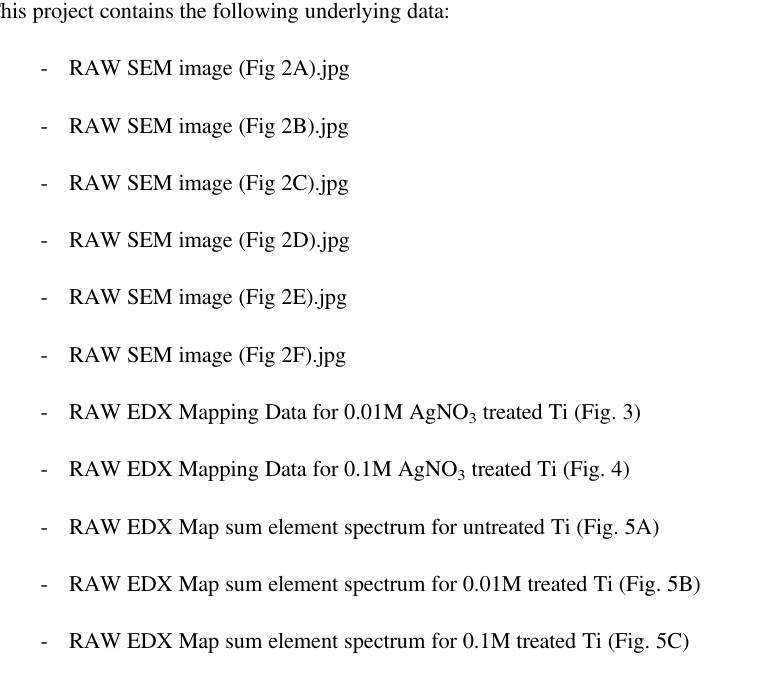
Figshare: SEM and EDX https://doi.org/10.6084/m9.figshare.17159234 14